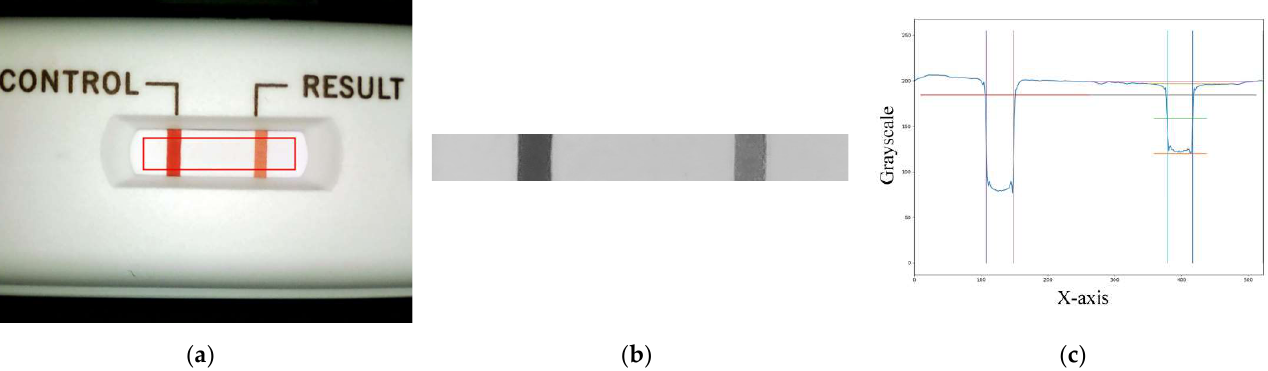
Figure 3. Region-of-interest (ROI) image and grayscale distribution map: ( a ) the captured image of the cassette with the ROI area marked with a red line, ( b ) the captured ROI image, and ( c ) the ROI grayscale distribution map.